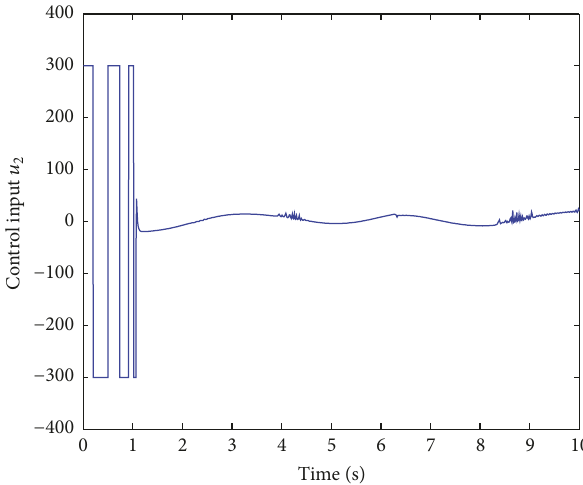
Figure 9: Response of the control input 𝑢 2